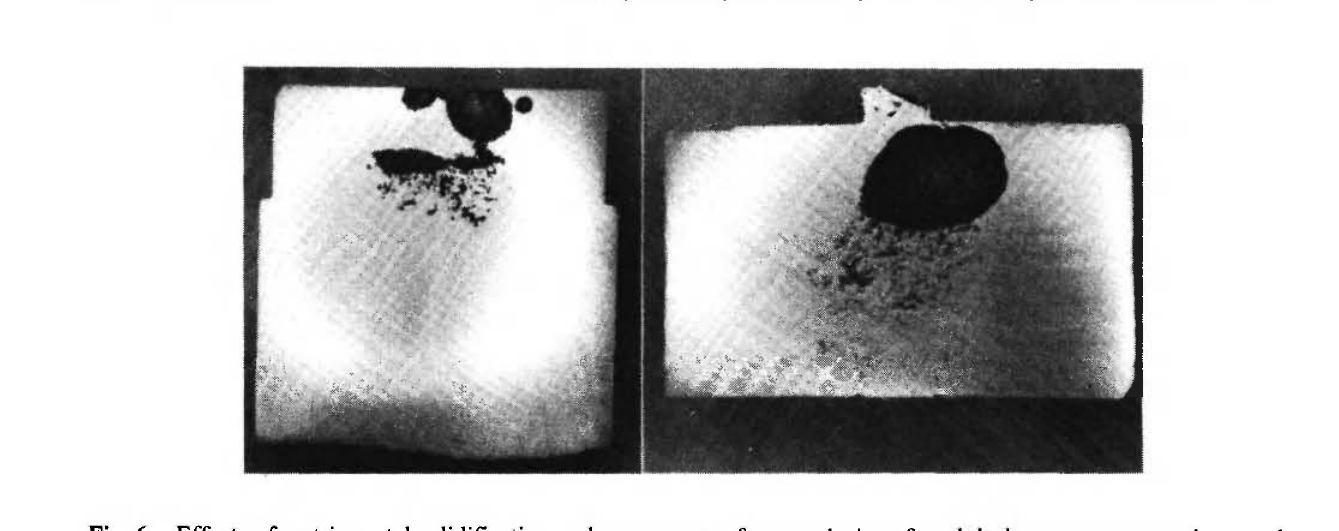
Fig. 6: Effects of matrix metal solidification and movements of gas occlusions found during attempts to make samples of the composite infiltrated in conditions similar to those shown in Fig. 5.